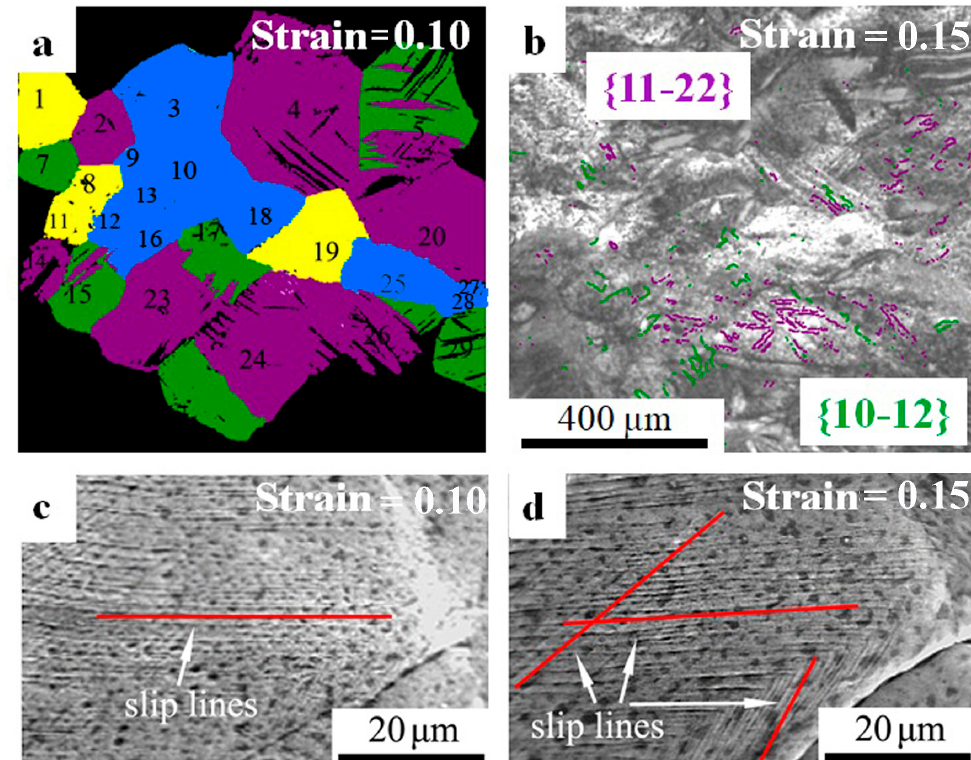
Figure 6. ( a ): Model diagram with a strain of 0.10. The places where twinning is going to nucleate and grow are painted green, purple, and yellow indicating {1012} twins, {1122} twins, and no twins, respectively. The place where existed twins become unidentified is painted in blue; ( b ): microstructure at 0.15 strain level, with {1012} twin boundaries (in green) and {1122} twin boundaries (in purple) identified by EDAX/TSL OIM Analysis 6.2; SEM morphology with a strain of ( c ): 0.10 and ( d ): 0.15.